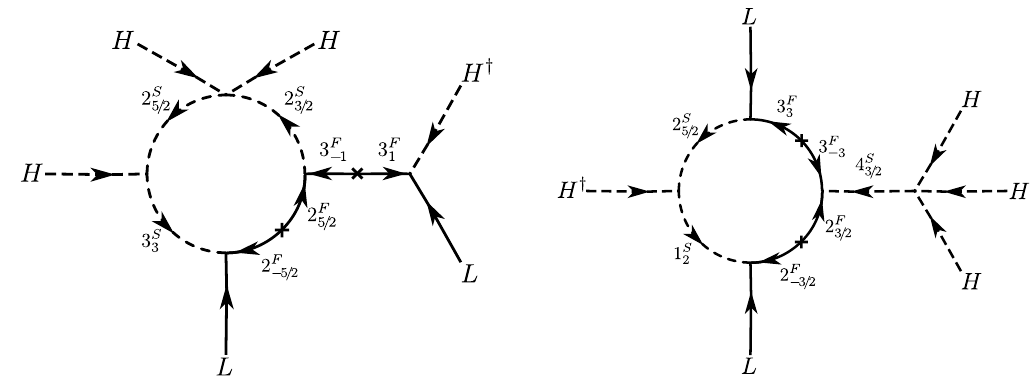
Figure 4 . Two examples for genuine 1-loop d = 7 diagrams. These examples have been chosen since they contain the smallest representations, for which genuine 1-loop d = 7 diagrams can be